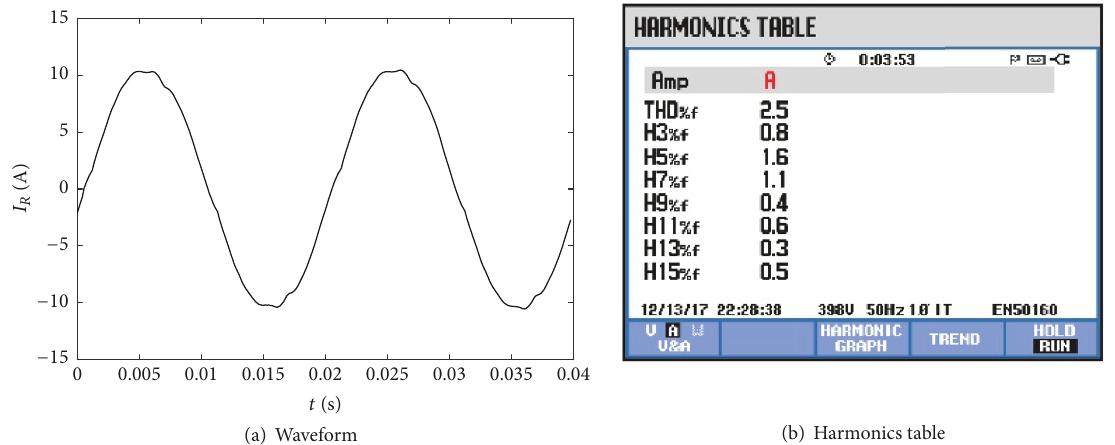
Figure 10: Waveform and harmonics table of current on ac side with feedforward harmonic mitigation